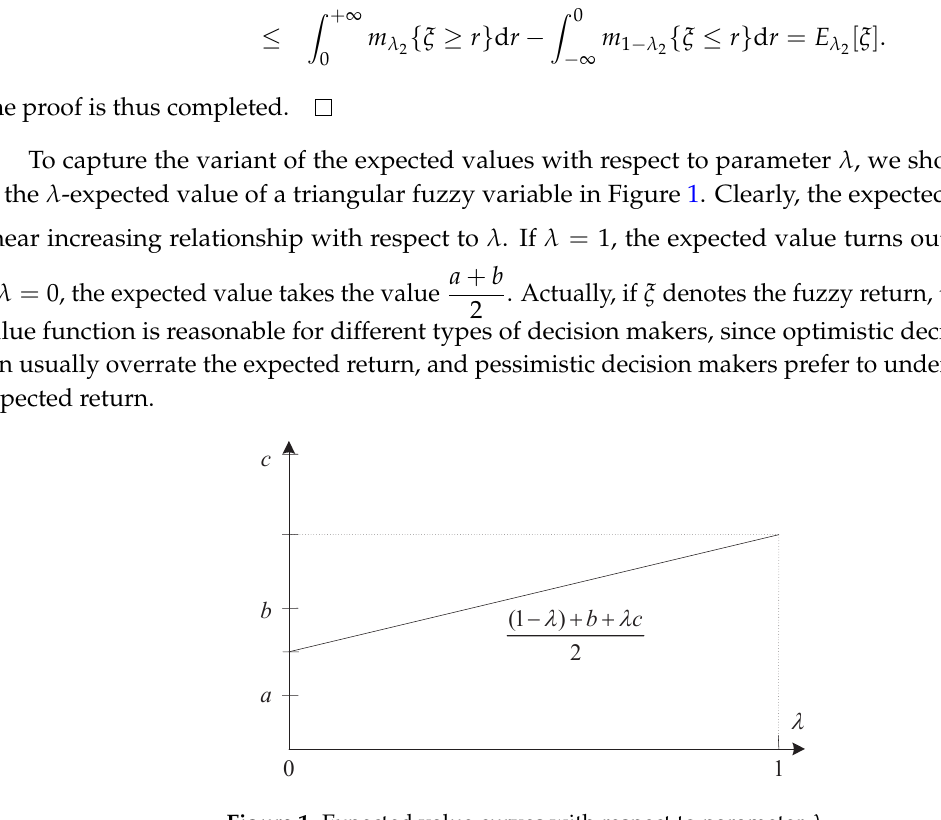
Figure 1. Expected value curves with respect to parameter λ